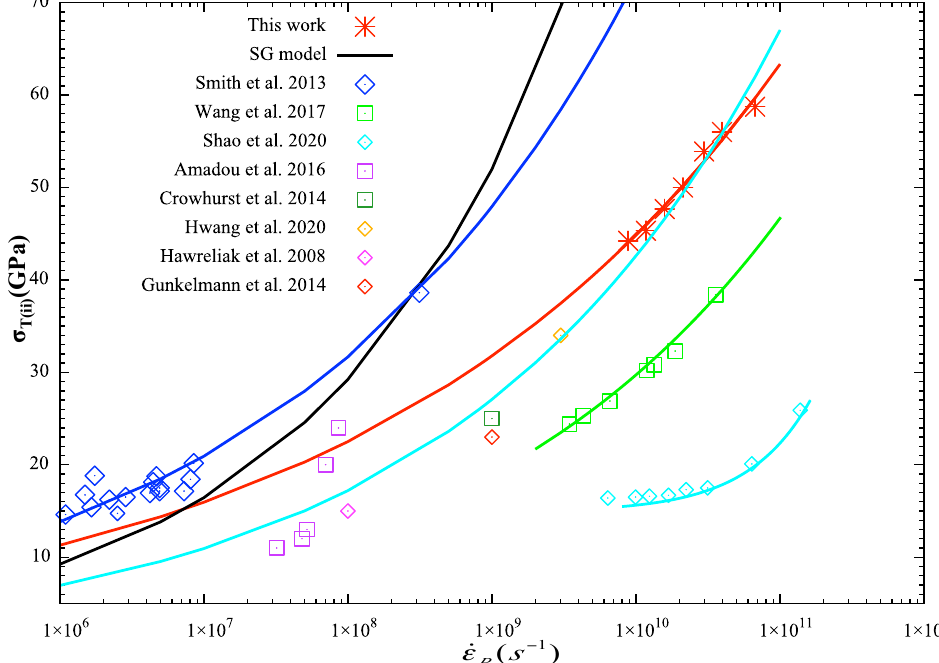
. ε c P (red stars),